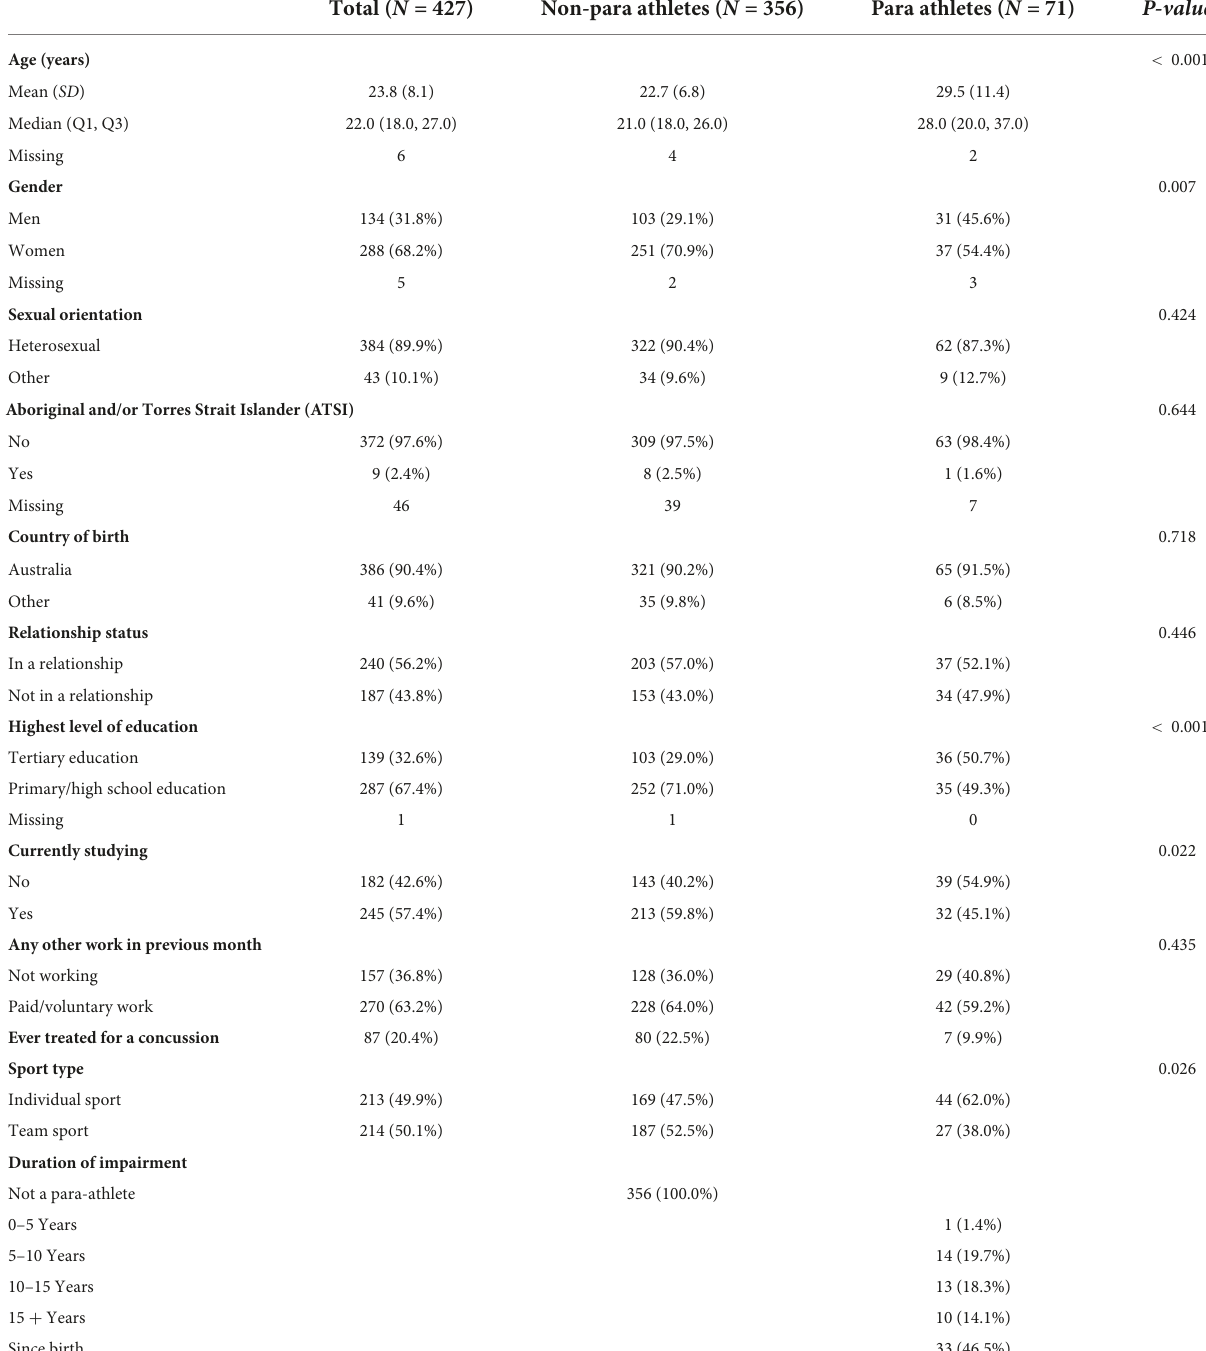
TABLE 1 Demographic and sports-related characteristics of non-para and para